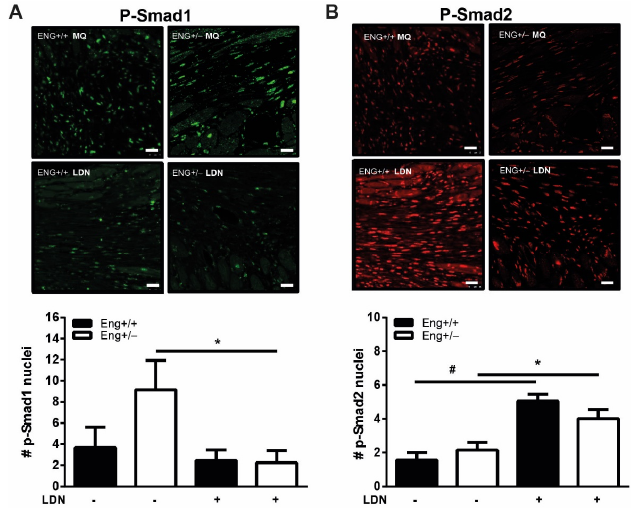
Figure 5. LDN decreases p-Smad1 and induces p-Smad2 in the infarct border zone. Paraffin sections were stained for ( A ) pSmad1 or ( C ) pSmad2 and quantified in ( B , D ) for positive stained nuclei in Eng+/+ and Eng+/ − mice treated with LDN or placebo. Representative images of heart sections 14 days post-MI are shown. N = 5–16 mice per group. Eng+/+ control N = 9, Eng+/ − control N = 5, Eng+/+ LDN N = 6, Eng+/ − LDN N = 16. Scale bars: 30 μ m. * p < 0.05; # p < 0.001. In both WT and Eng+/ − mice, LDN treatment significantly improved cardiac function (Figure 6A) and reduced infarct size (Figure 6B). Investigating the infarct border zone of these animals in more detail revealed that LDN treatment increased capillary density in WT hearts, but had no effect on the number of capillaries in Eng+/ − mice. Interestingly, LDN treatment did not change the number of arteries in WT hearts, whereas in Eng+/ − animals, the number of arteries increased significantly (Figure 6C–E).